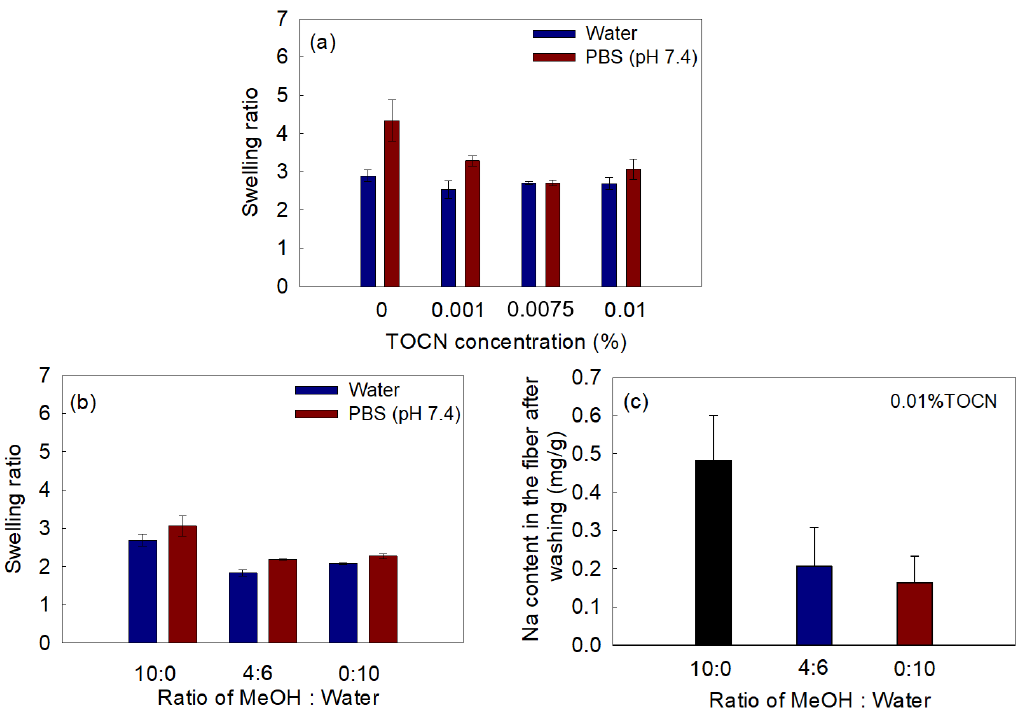
Fibers 2023 , 11 , x FOR PEER REVIEW Figure 5. Results of the swelling test of fibers ( a ) at various TOCN concentrations (MeOH:water = 10:0) and ( b ) at various ratios of MeOH to water as the washing agent (0.01%TOCN), and ( c ) Na content in the fibers after washing at various ratios of MeOH to water (0.01%TOCN).